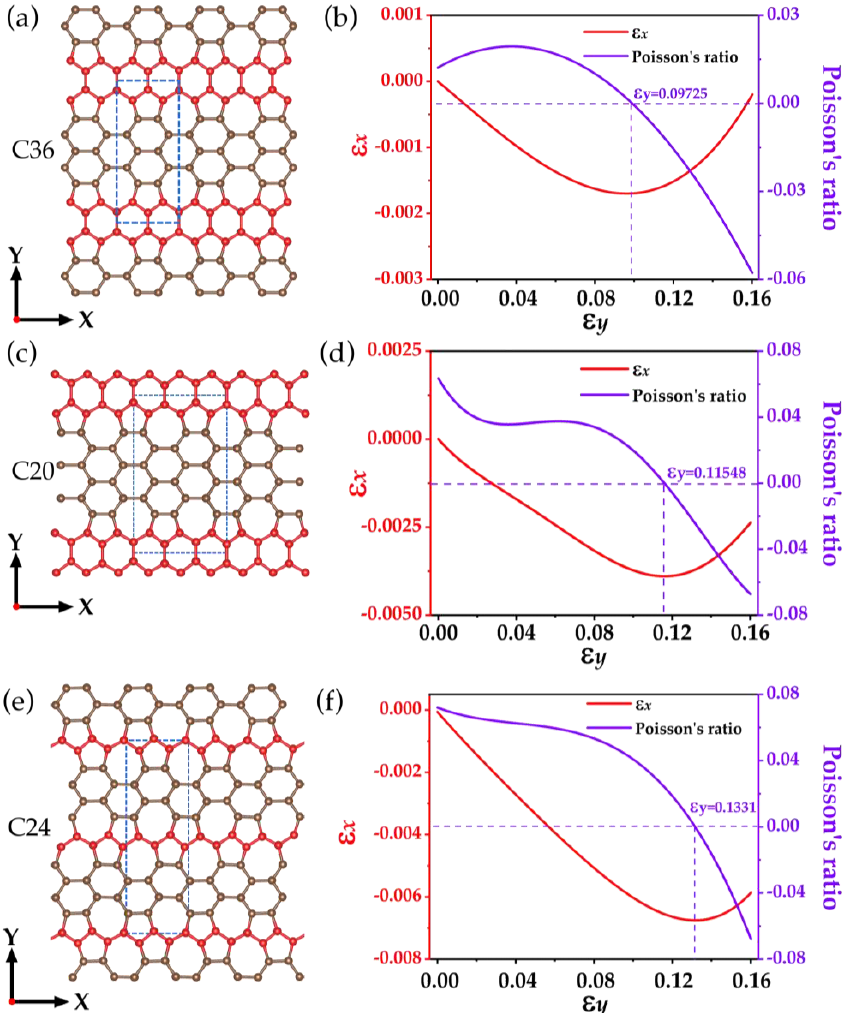
Figure 4. Structure and mechanical properties of C36, C20, and C24 ( a , c , e ). Three structures containing zigzag carbon chains are marked as C36, C20, and C24, separately. The mechanical responses of structures ( a , c , e ) are shown in ( b , d , f ), separately. The red line indicates the response of the driven strain under the uniaxial strain along the y -axis, and the purple line represents the Poisson’s ratio under the uniaxial strain along the y -axis.